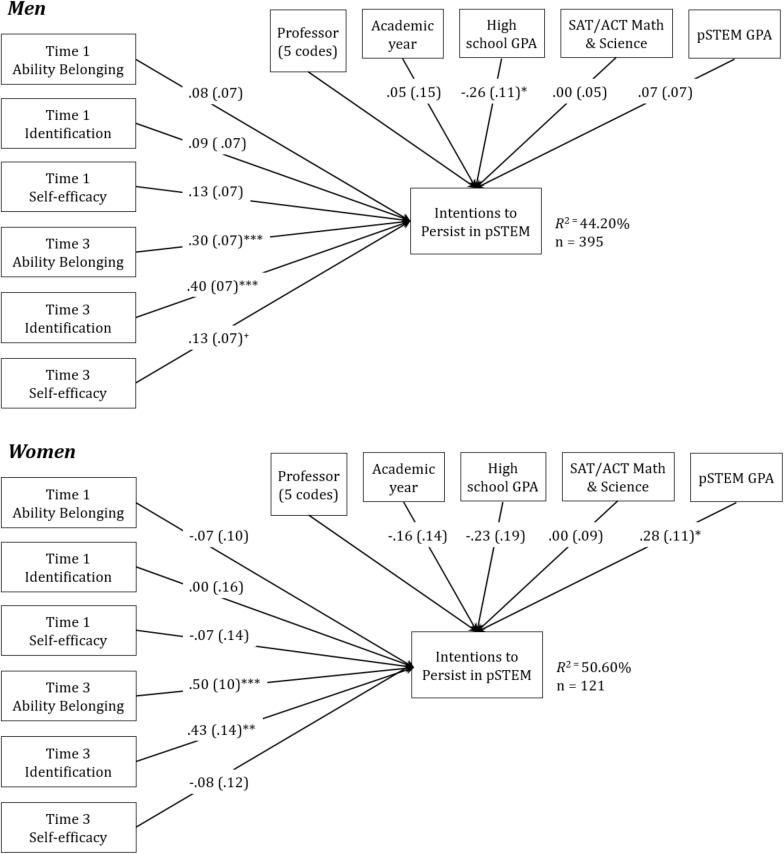
Path models depicting relationships among ability belonging and intentions to persist for men and women, controlling for professor, academic year, and prior and ongoing performance. Unstandardized betas are presented, with Standard Errors in parentheses. For simplicity, paths for professor are not depicted.